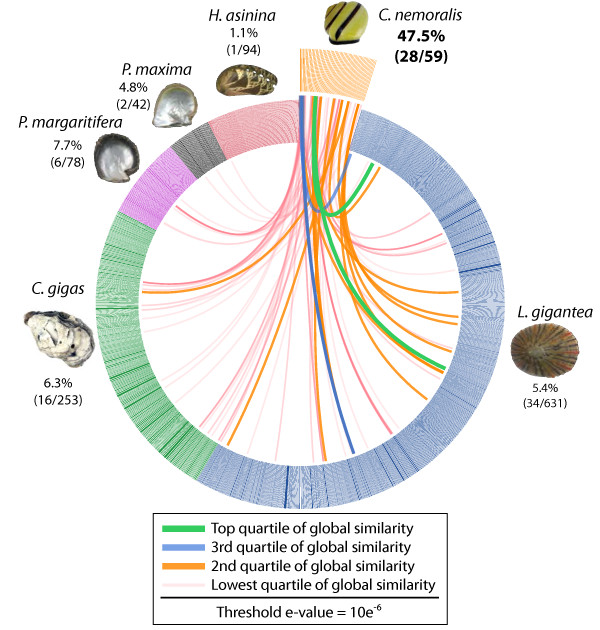
BLASTp comparisons of the C. nemoralis shell proteome against the shell proteomes derived from 3 bivalves and 2 gastropods. Individual lines spanning the ideogram connect proteins that share significant similarity (e values < 10e-6). Transparent red lines connect proteins with the lowest quartile of similarity (with a threshold of 10e-6) and green lines with the highest quartile of similarity. The percentage of each shell proteome that shared similarity with the C. nemoralis proteome is provided. Shell proteome datasets were derived from the following publications: P. maxima from [30]; P. margaritifera from [30]; H. asinina from [6] and [4]; L. gigantea from [33] and [5]; C. gigas from [7].